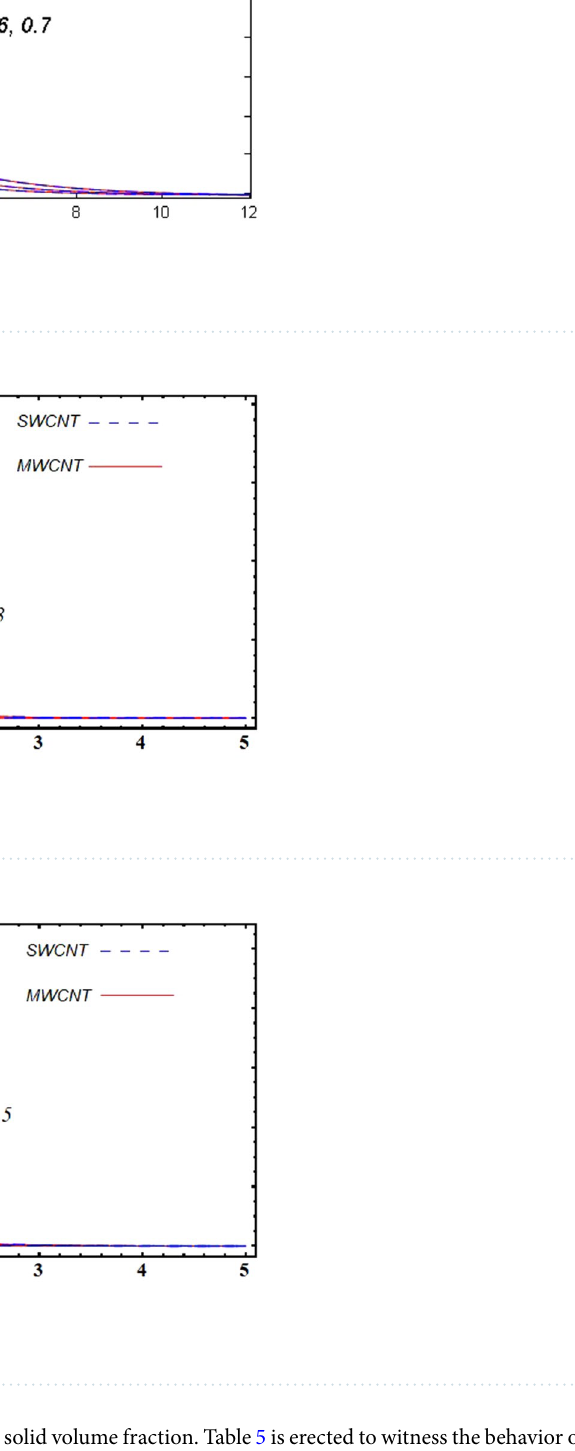
radiation parameter, Biot number, and solid volume fraction. Table 5 is erected to witness the behavior of param- eters versus the Sherwood number. For the growing estimates of the buoyancy ratio parameter and concentration stratification, Sherwood number is on the decline and grows versus numerical values of the Schmidt number